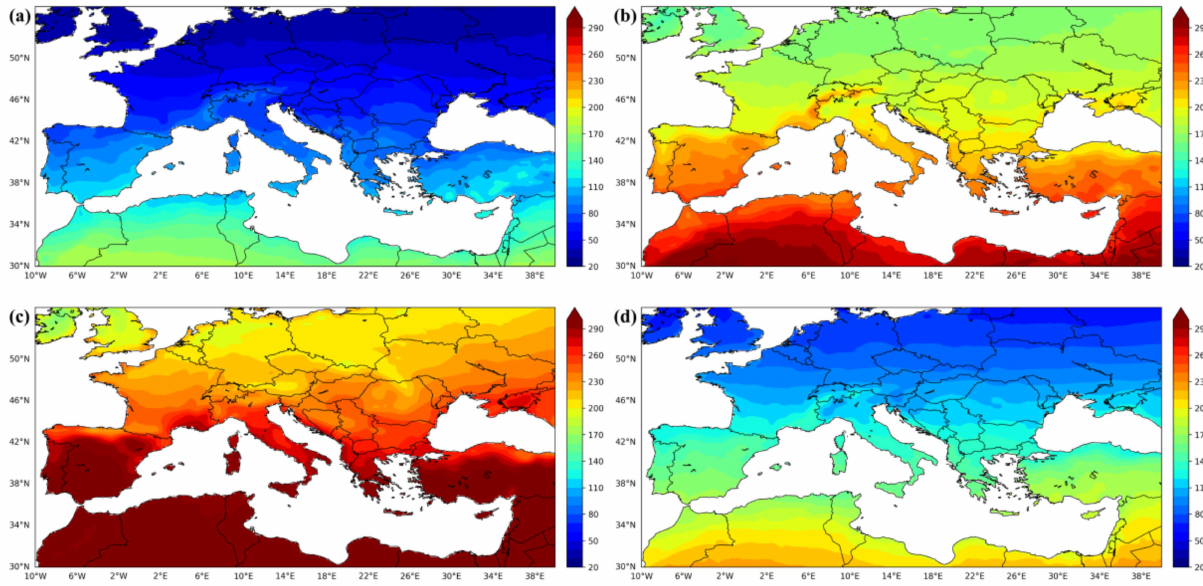
Figure 10. Mean seasonal SWGI (W/m 2 ) over Euro-Mediterranean region for the period 1981–2020 from ERA5-Land for ( a ) winter (DJF); ( b ) spring (MAM); ( c ) summer (JJA); and ( d ) autumn